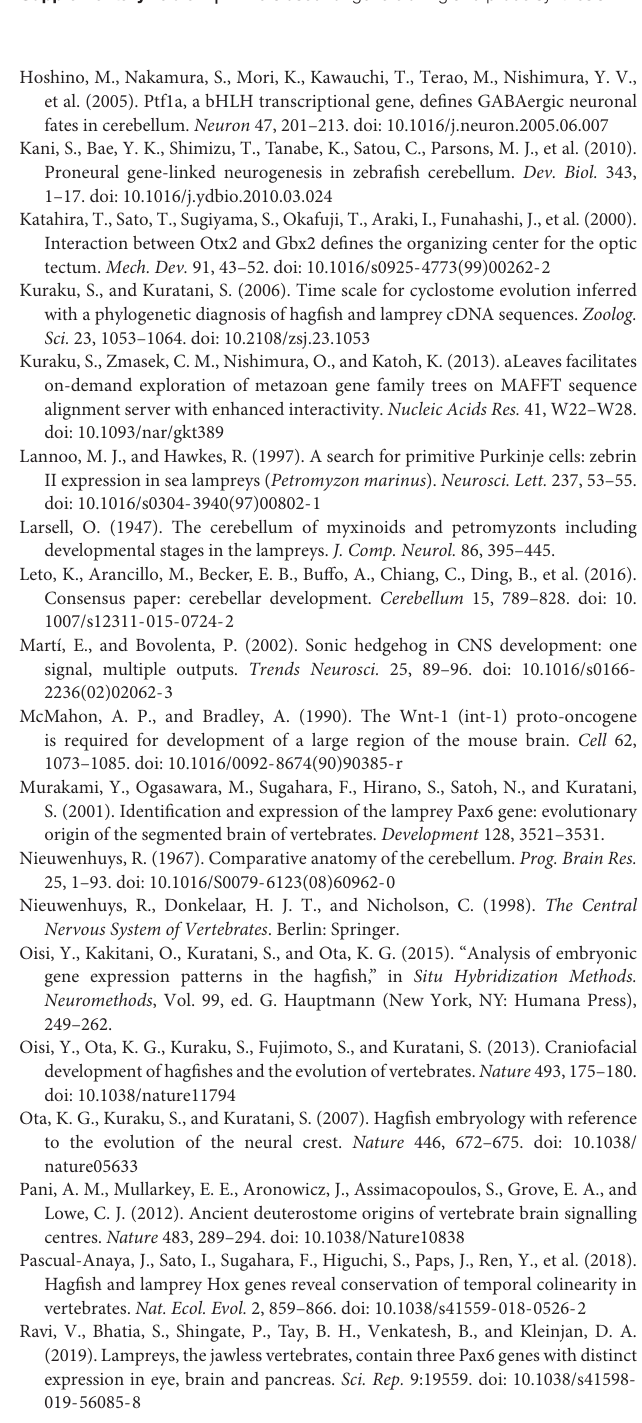
Supplementary Figure 2 | Temporal expression of the NeuorD in the rhombomere 1. Dorsal views of the head region of the lamprey stages 25 (A) , 26 (B) , and 27 (C) . Arrowheads in (B,C) indicate the expression in the rhombomere 1. gV 1 , ophthalmic ganglion; gV 2 , 3 , maxillomandibular ganglion.